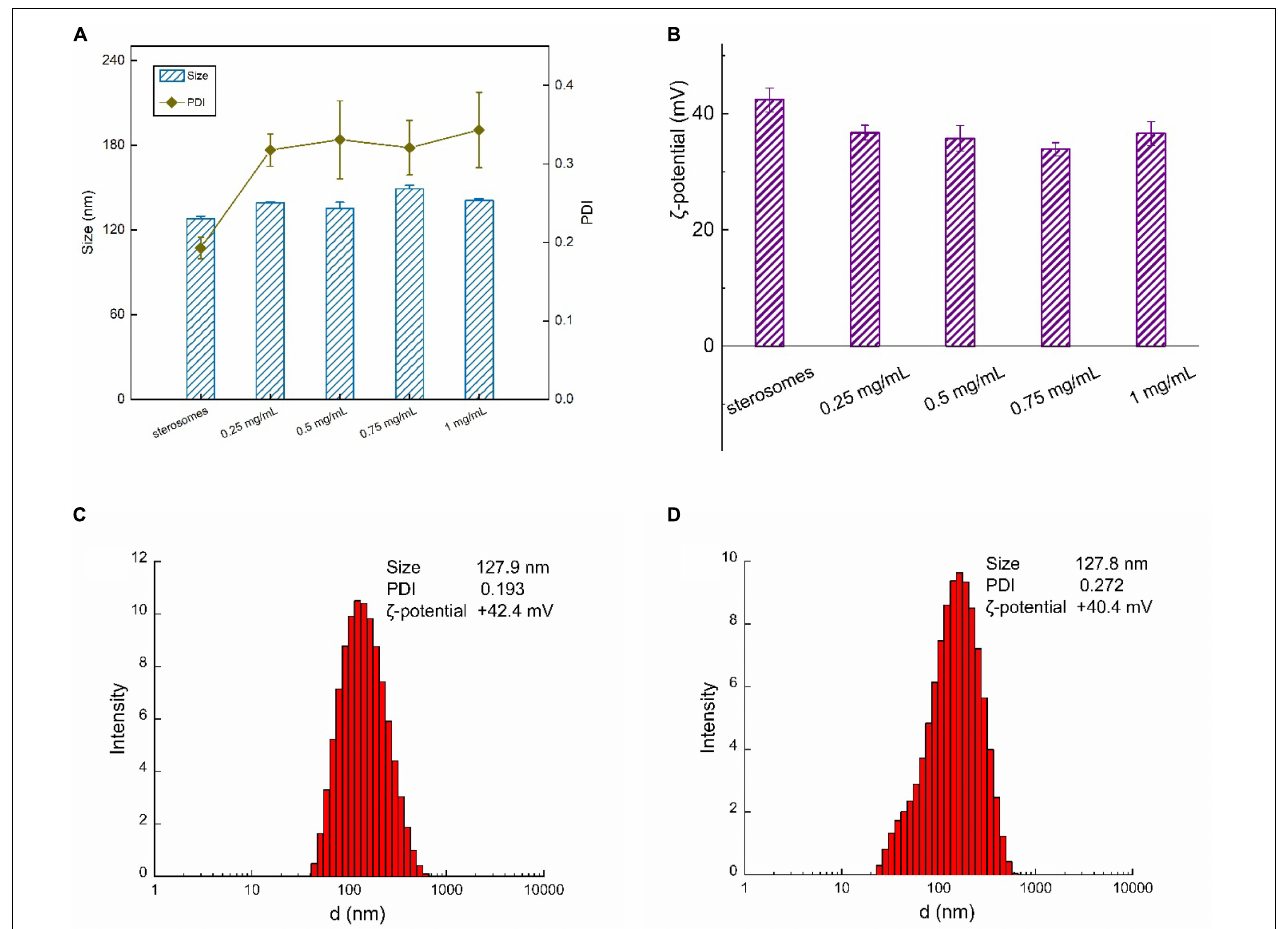
FIGURE 2 | Size and ζ -potential of CYM-loaded sterosomes with various CYM concentrations: (A) size distribution and PDI; (B) ζ -potential with various CYM concentrations ranging from 0.25 to 1 mg/mL; size distribution and ζ -potential of (C) sterosomes; (D) CYM-loaded sterosomes (1 mg/mL